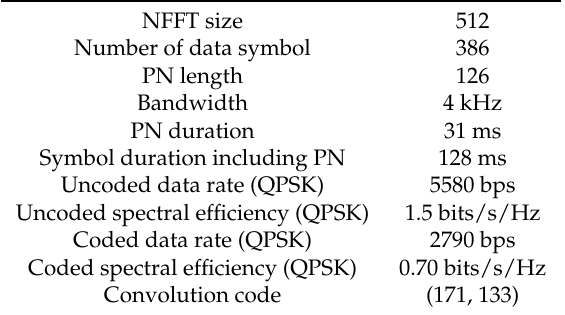
Table 1. Single carrier with frequency domain equalization communication system